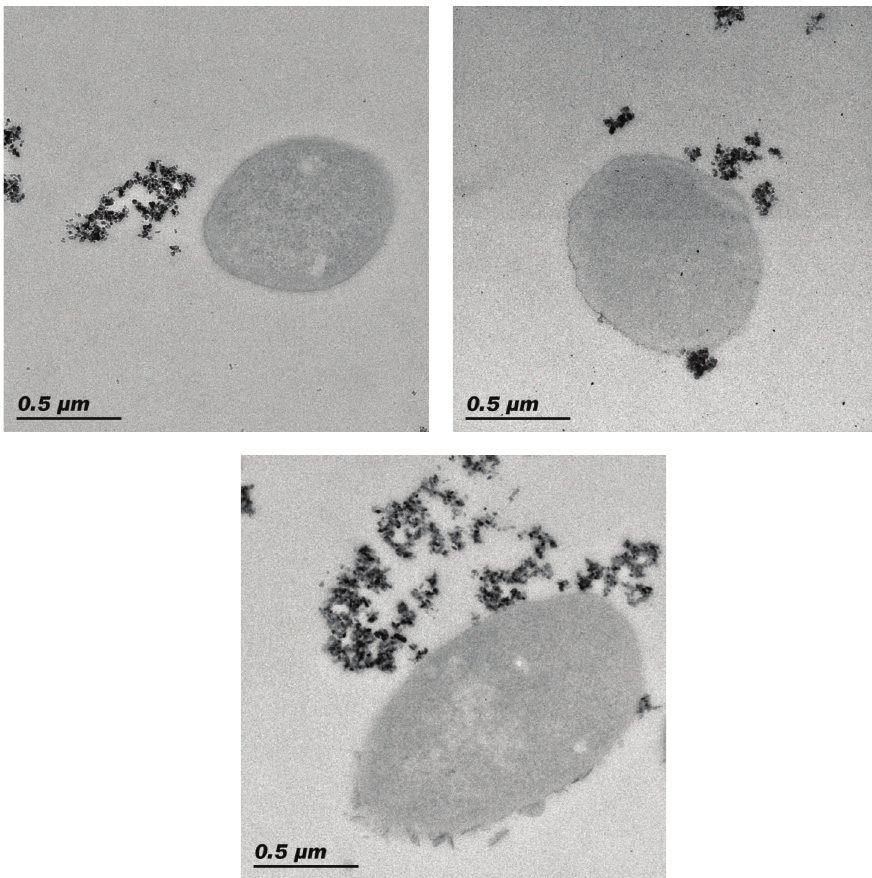
Figure 15: TEM biomicroscopy of TiO 2 -polyester 5% (HT) interacting with the E. coli cell wall in the dark: (i) upper left hand side: time zero, (ii) upper right hand side: time 30 min, and (iii) central lower position: time 120 min. For more details see